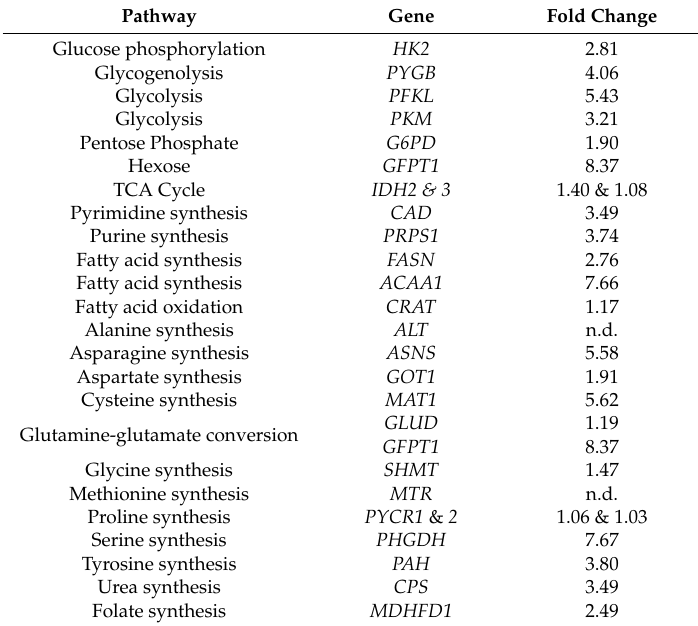
Table 1. Rate limiting enzymes for central metabolic pathways and the ration of their expression in 3D spheroids compared to 2D exponential growth. n.d. not